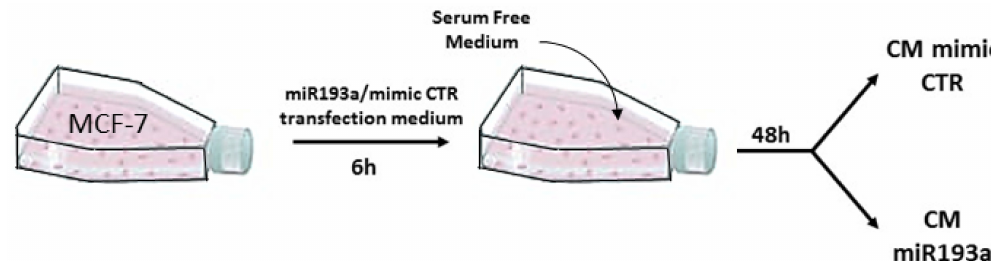
Figure 1. A representative scheme of Conditioned media formation. MCF-7 cells are grown on 75 cm 2 tissue culture flasks and transfected with miR193a-3p and its relative mimic control. Medium was replaced with serum free medium and collected after 48 h. Same approach was used to collect CM from MDA-MB-231 BC